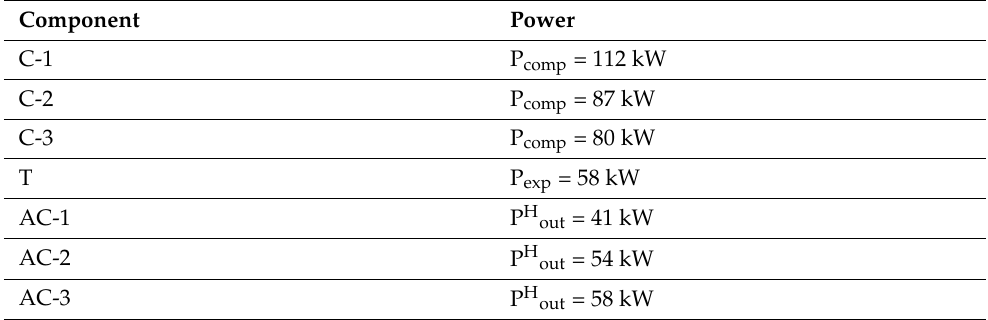
Table A15. This power data refer to operating unit in